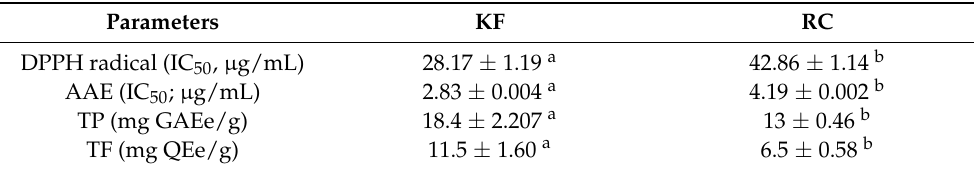
Table 4. Evaluation of antioxidant activity (IC 50 ; µ g/mL), total polyphenols, and total flavonoids of kudzu flower and red clover